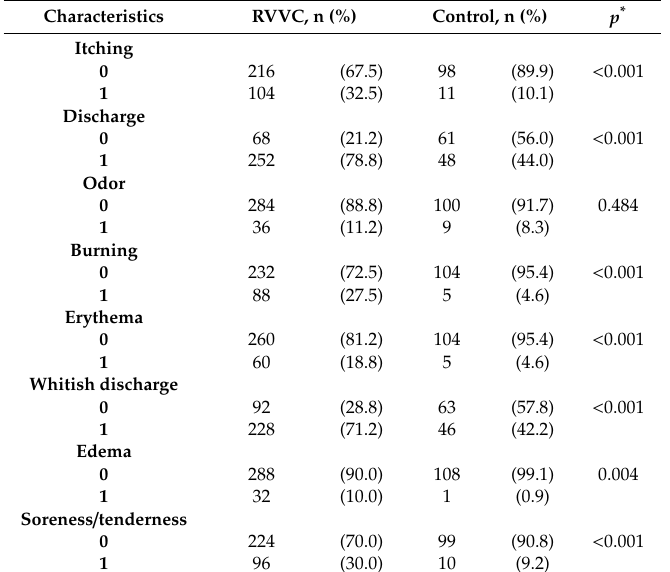
Table 3. Clinical data between the examined